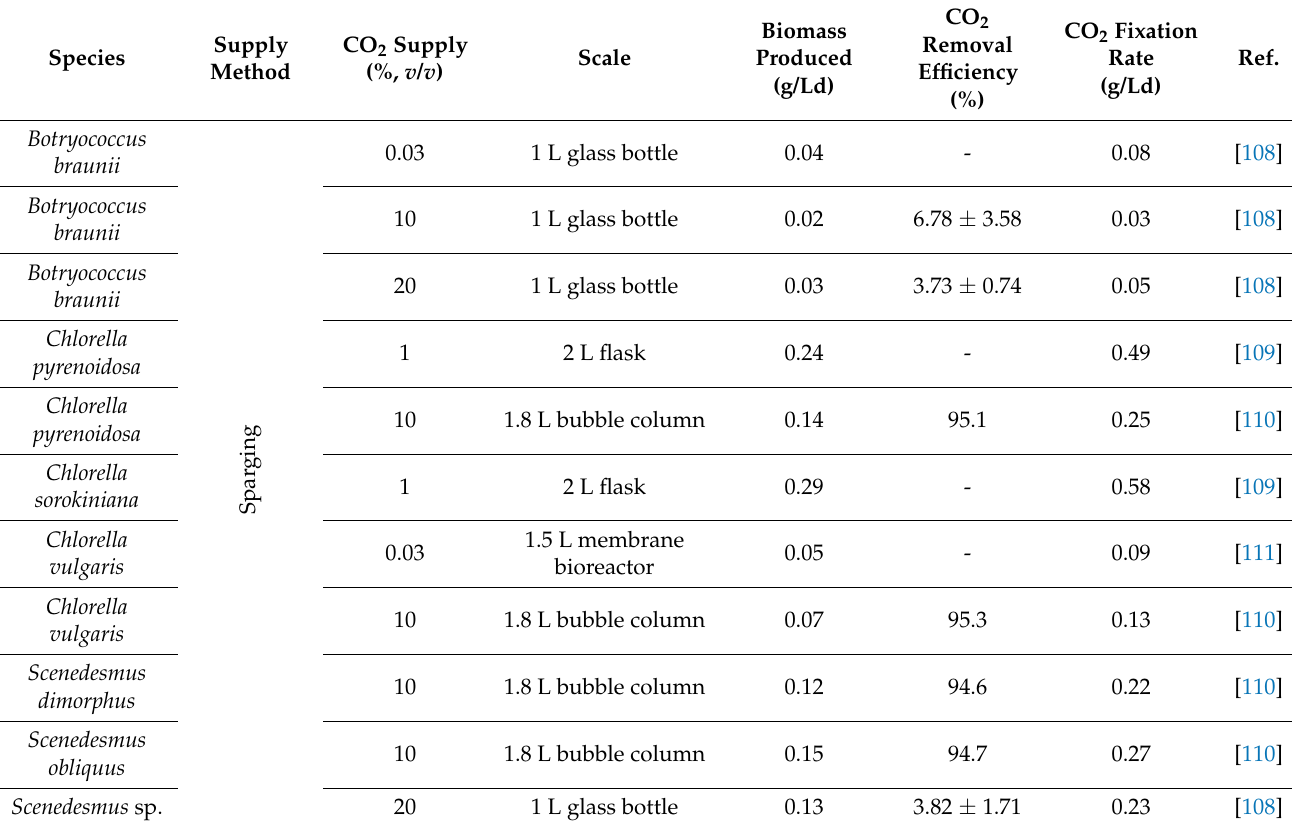
Table 4. Biomass production and CO 2 sequestration rates as a function of pre-treated gas input